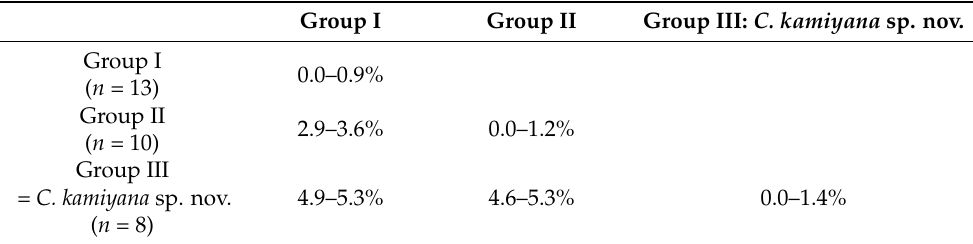
Table 1. Pairwise rbc L sequence divergences between Caloglossa ogasawaraensis “groups” designated by Kamiya and West [26].